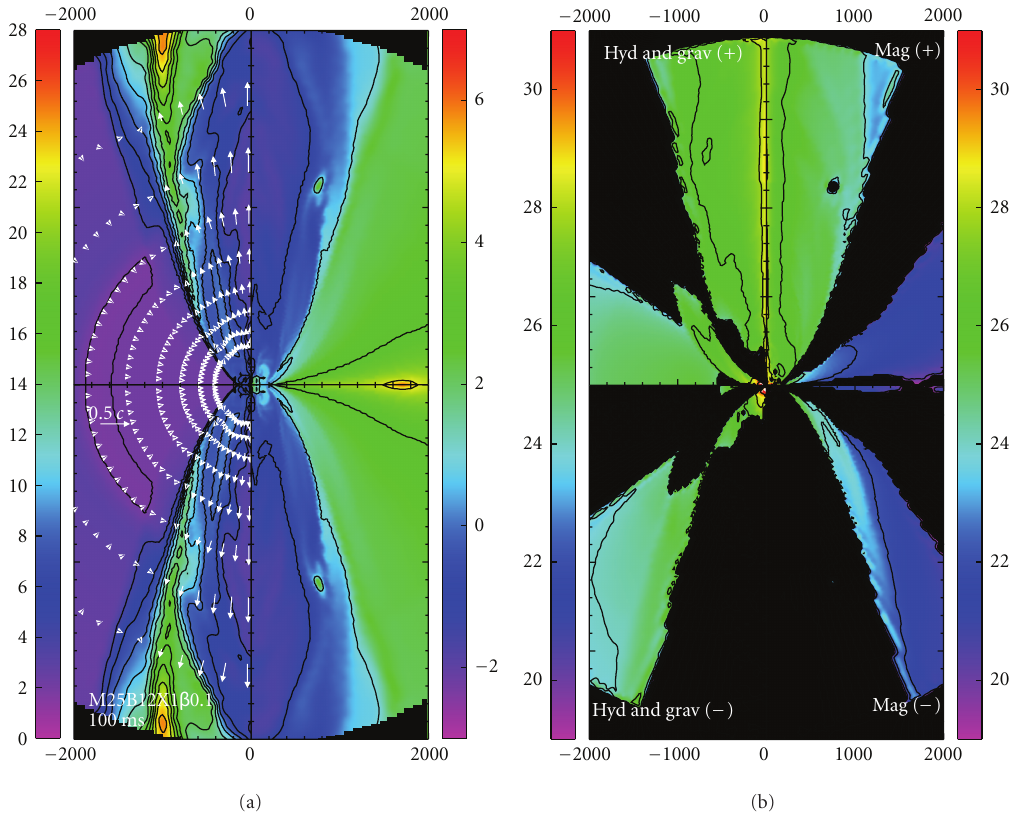
Figure 23: Left panel shows distributions of entropy ( k B /baryon) (left) and logarithm of plasma β (right) for model B12X1 β 0.1 at 100 ms after bounce. The white arrows in the left-hand side show the velocity fields, which are normalized by the scale in the middle left edge (0 . 5 c ). Right panel shows the sum of the hydrodynamic and gravitational parts (indicated by “hyd and grav” in the left-hand side) and the magnetic part (indicated by “mag” in the right-hand side), respectively. The top and bottom panels represent the positive and negative contribution (indicated by (+) or ( − )) to A E 2 20 , respectively (see text for more detail). The side length of each plot is 4000 (km) × 8000 (km). This figure is taken from